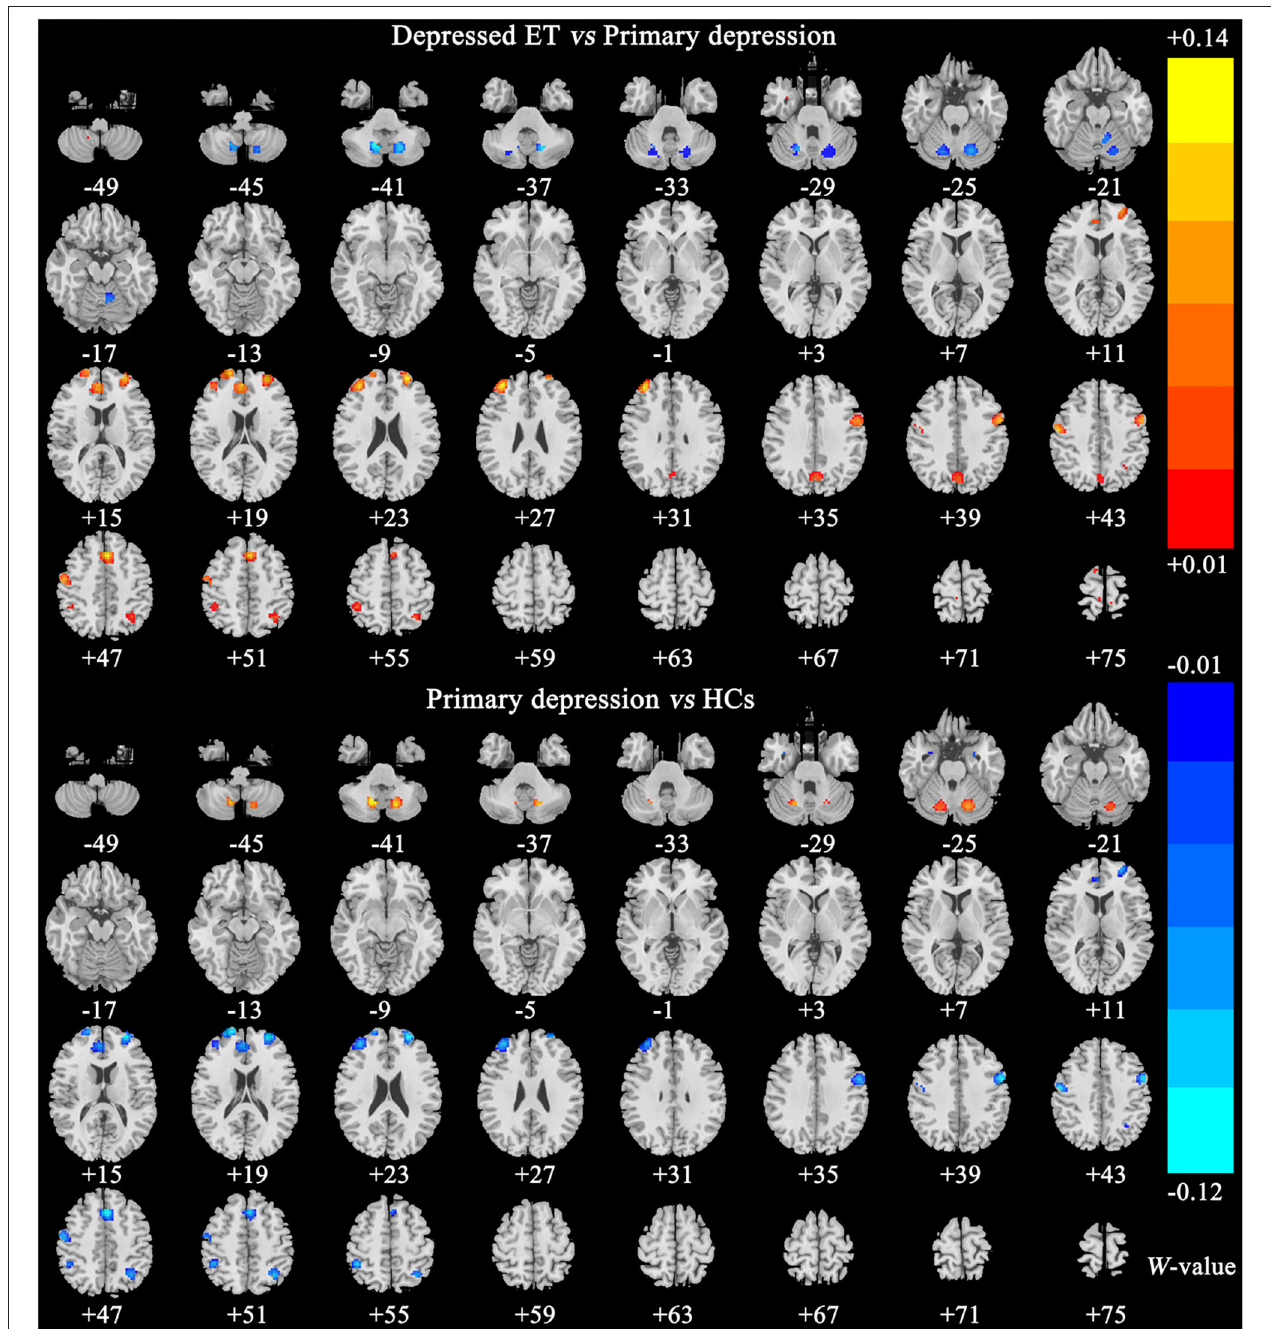
FIGURE 3 | The brain regions of significant discriminative features in classification of depressed ET vs. primary depression, and primary depression vs. HCs. ET, essential tremor; HCs, healthy controls.